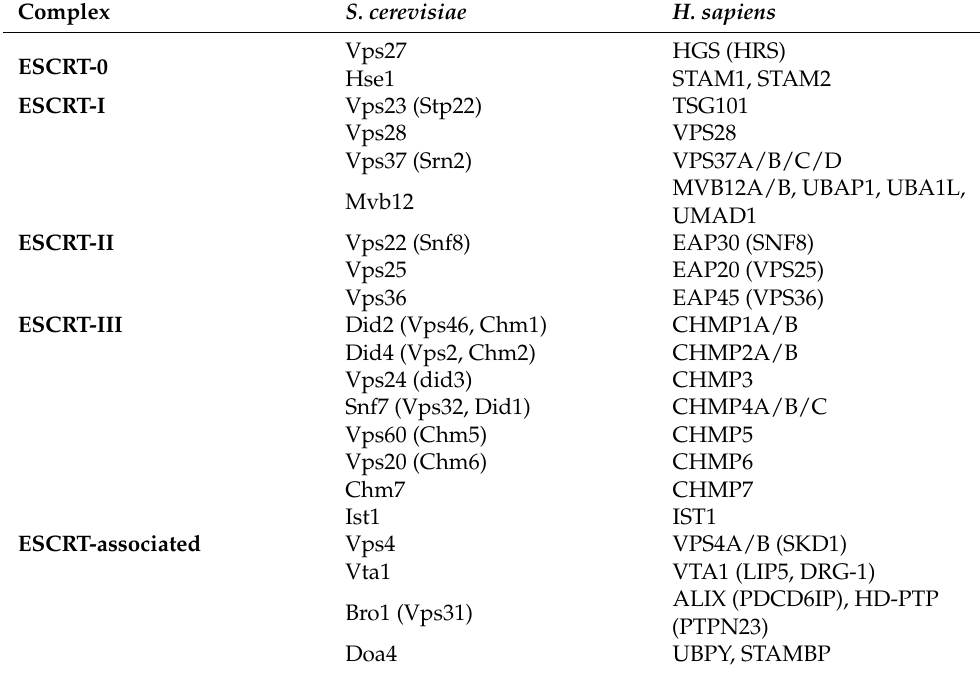
Table 1. ESCRT complexes and their protein subunits in yeast and humans.